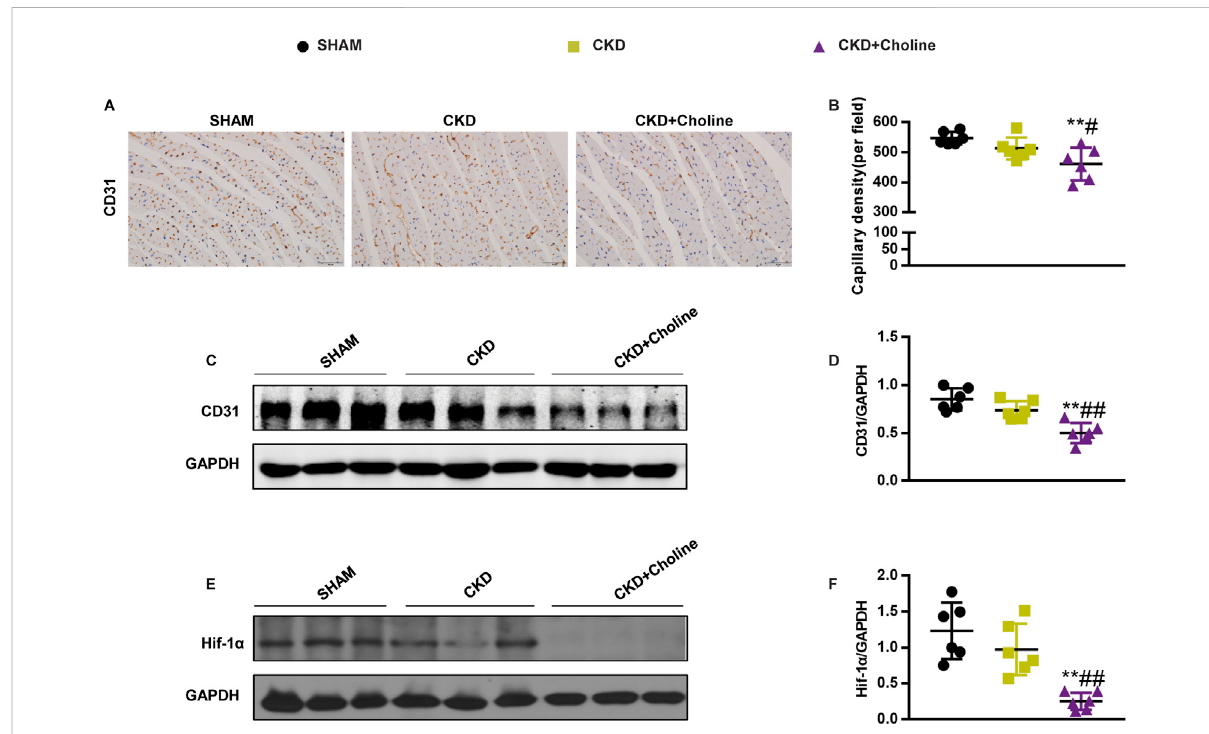
FIGURE 6 Dietary choline (1.2%) inhibits cardiac angiogenesis in 5/6Nx mice on a high-choline diet. (A) Representative micrographs of immunohistochemistry staining of CD31 in the heart. Scale bar = 50 μ m. (B) Graphical representation of capillary density analysis. (C) The protein levels of CD31 were measured by western blotting. (D) Graphic representation of relative abundance of CD31 normalized to GAPDH. (E) The protein levels of Hif-1 α were measured by western blotting. (F) Graphic representation of relative abundance of Hif-1 α normalized to GAPDH. The